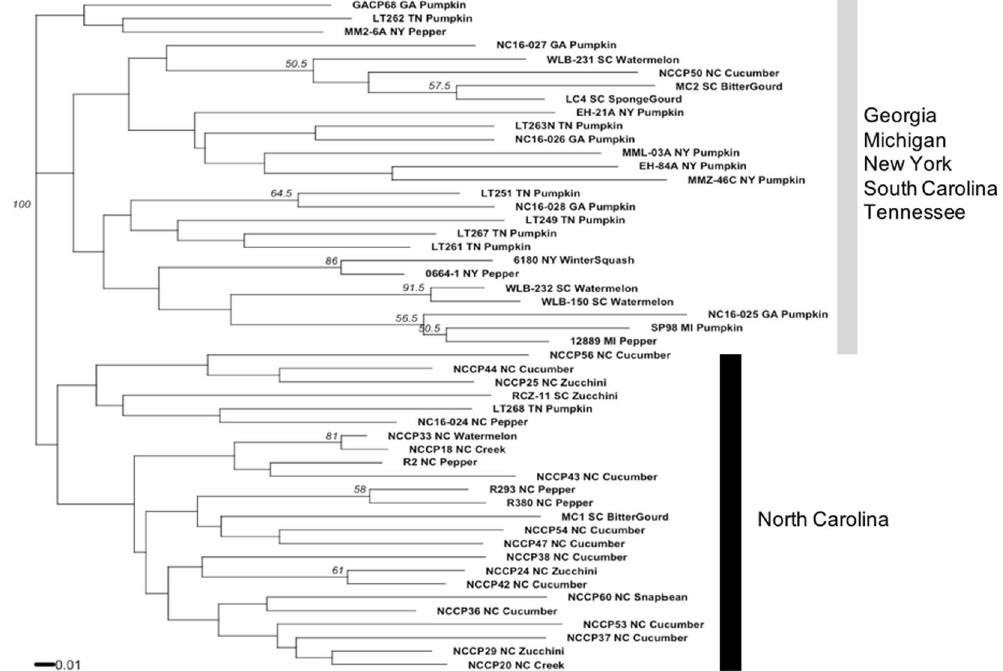
Figure 2. UPGMA tree with 1,000 bootstrap replicates based on Provesti’s distance for 50 P . capsici isolates. Tip labels define the isolate information by isolate name, state (NC: North Carolina, SC: South Carolina, NY: